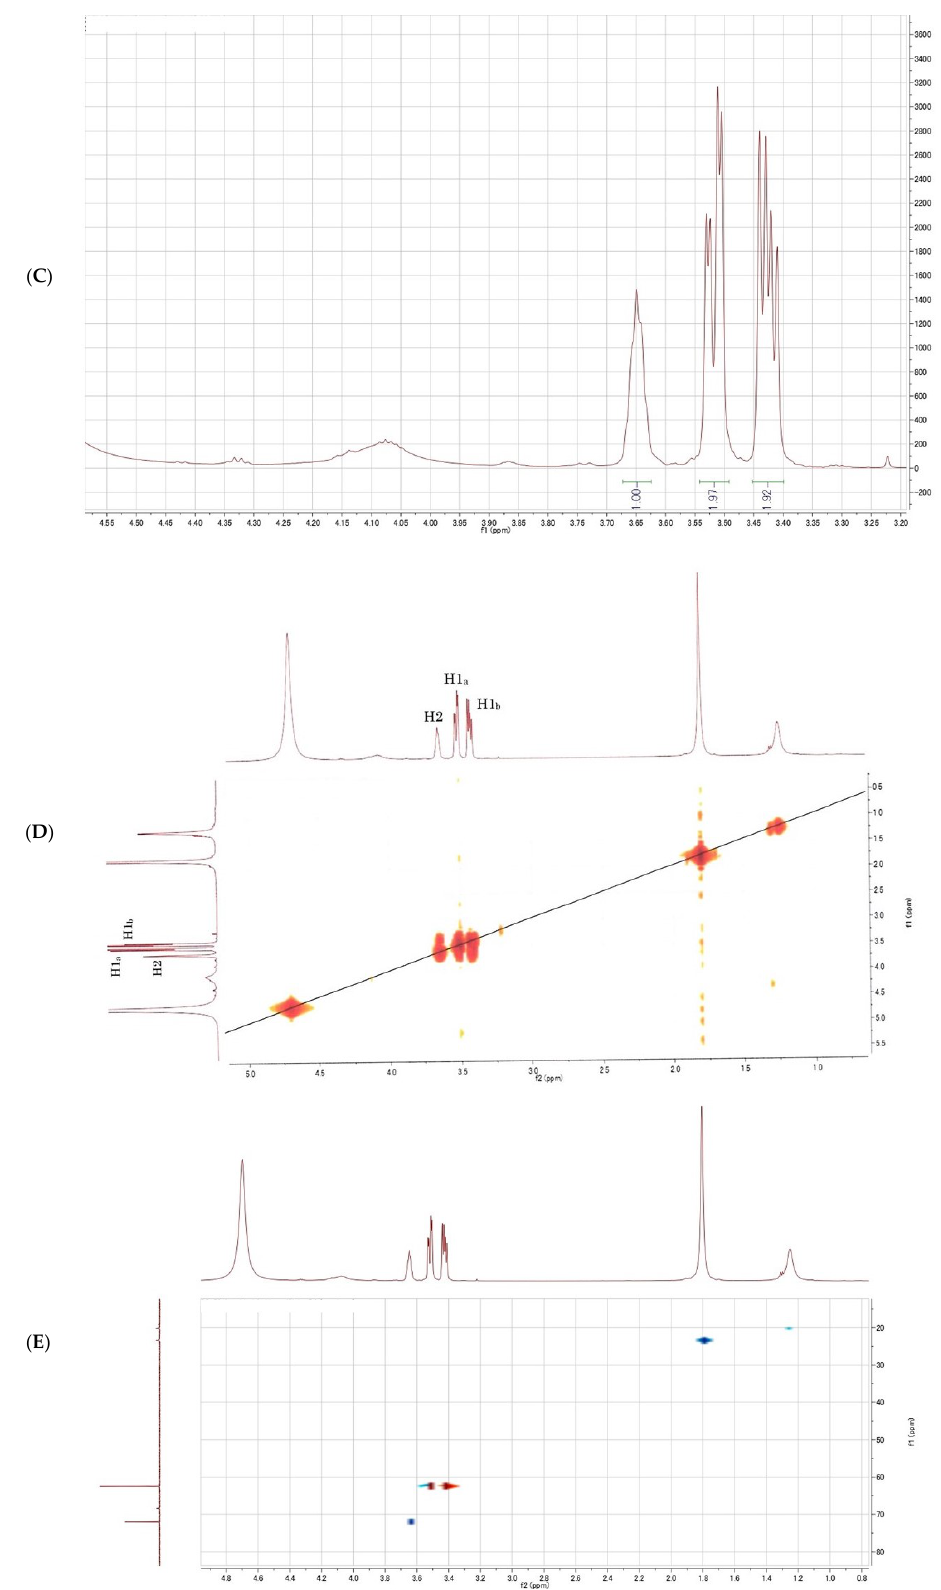
Figure 4. Nuclear magnetic resonance (NMR) spectrum of glycerol; ( A ) ¹H-NMR spectrum of the purified fraction; ( B ) ¹H-NMR spectrum of the purified fraction (enlarged); ( C ) ¹H-¹H COSY spec- trum of the purified fraction; ( D ) ¹³C-NMR spectrum of the purified fraction; ( E ) ¹H-¹³C HSQC spec- trum of the purified fraction.